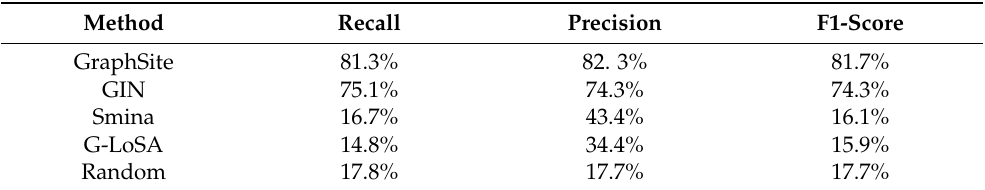
Table 2. Classification performance against the benchmarking dataset. GraphSite is compared to the graph isomorphism network (GIN), molecular docking with smina, pocket matching with G-LoSA, and a random classifier. Precision, recall, and F1-score are class-weighted.